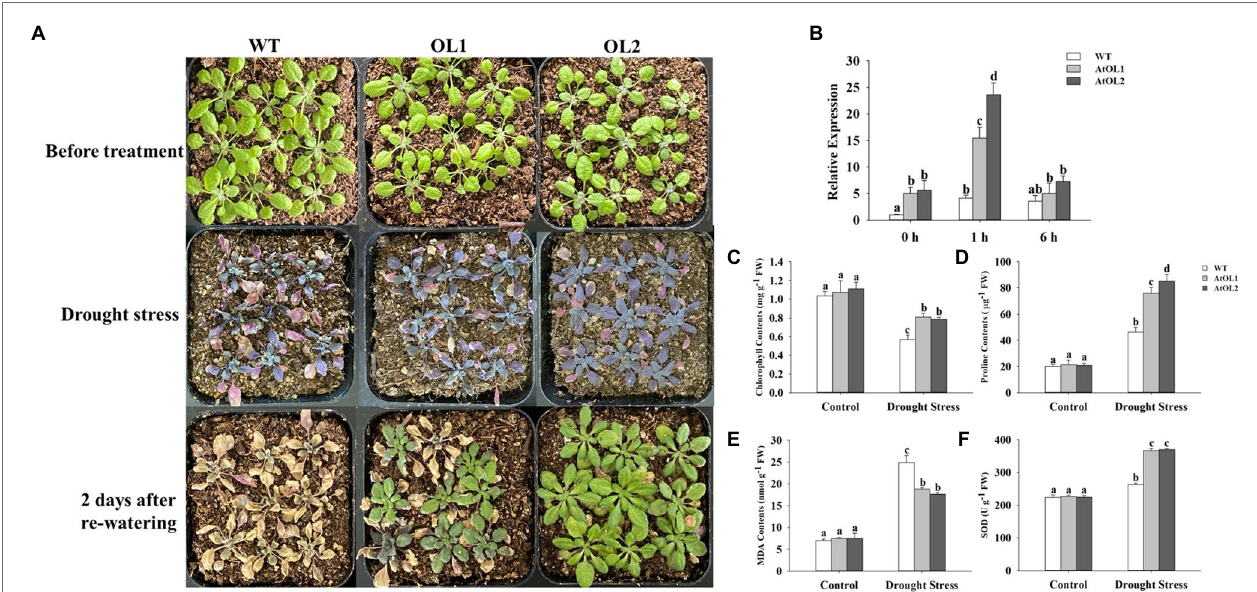
FIGURE 10 | Overexpression of AhLOX29 improved tolerance to drought stress in transgenic Arabidopsis. (A) Phenotype of control and transgenic plants before and after drought stress treatment; (B) the relative expression level of AhLOX29 in WT and transgenic plants; (C) chlorophyll contents; (D) proline contents; (E) MDA contents and (F) SOD